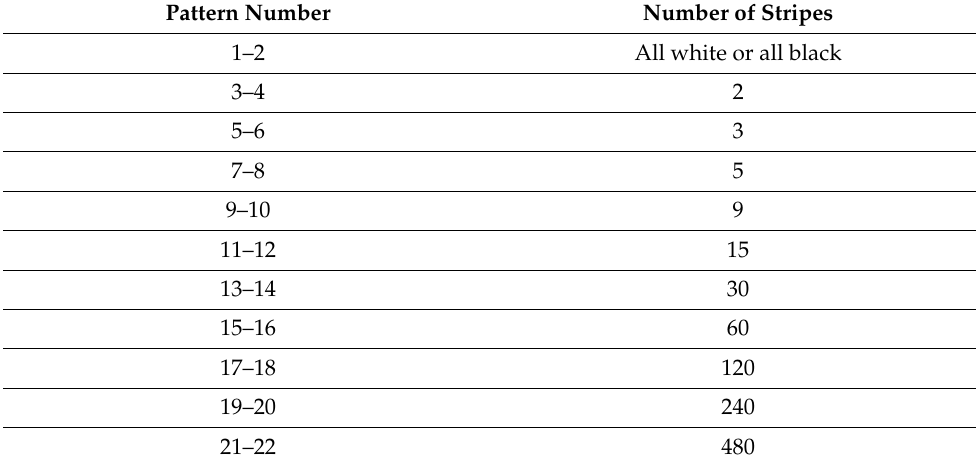
Table 1. Structured light